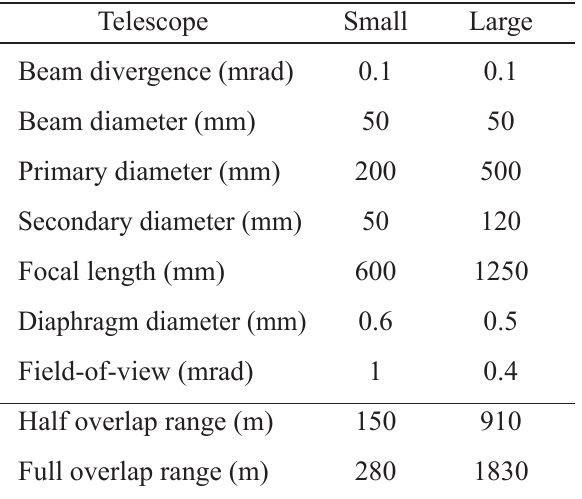
Table I. Inputs used for geometrical form factor calculations and results.